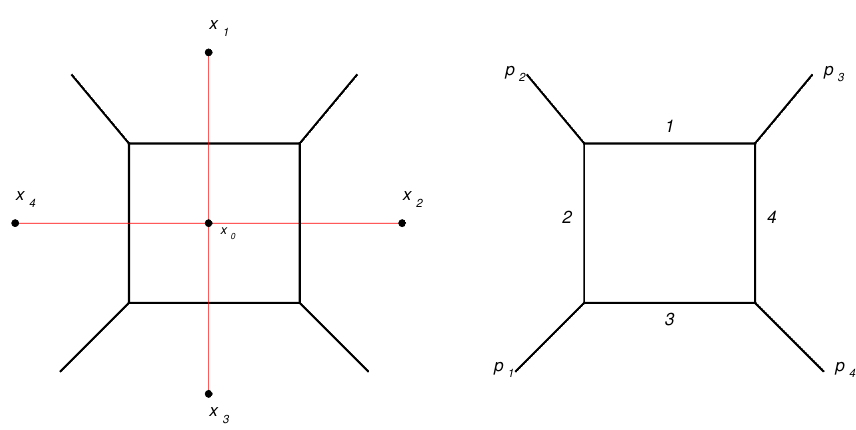
Figure 1 . Scalar box integral in dual and standard variables. Numbers on the propagators numer- ate corresponding alpha